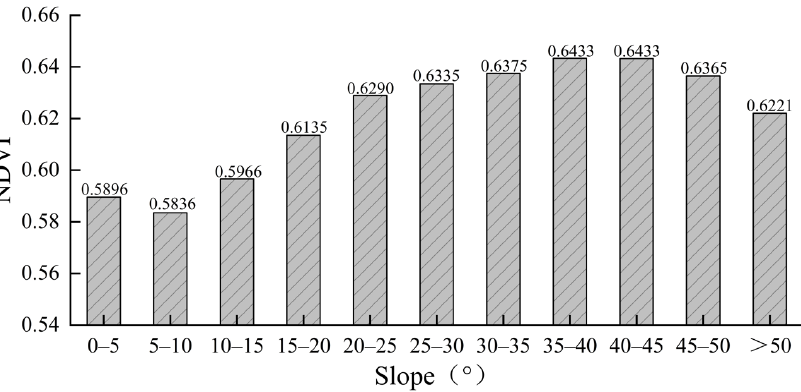
Figure 9. Relationship between average NDVI and slope in the growing season in the Minjiang River Basin from 2001 to 2020.